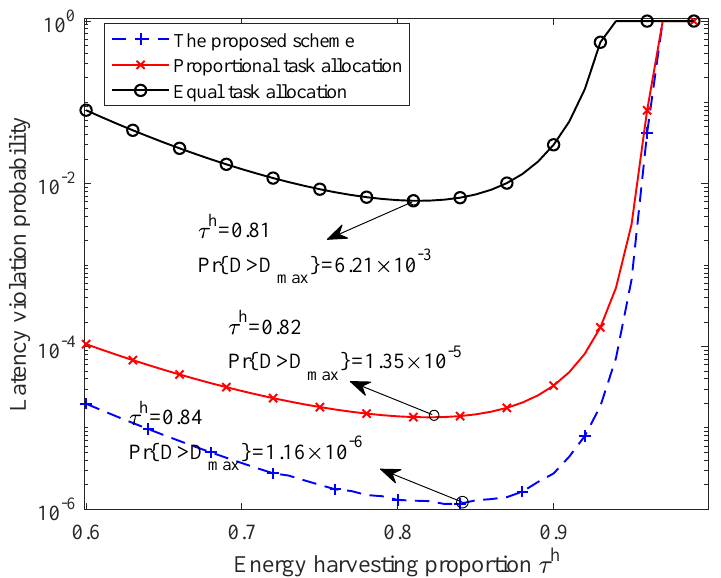
Figure 7. Performance comparison between the proposed scheme and the baseline schemes.